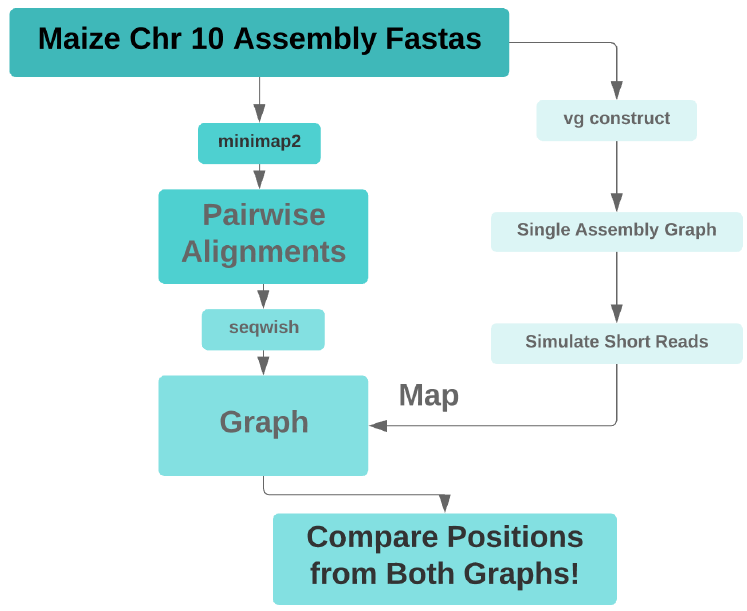
Figure 3. Pipeline diagram for mapper evaluation on Zea mays graphs. After constructing graphs with vg construct and with minimap2 and seqwish (Graph method 1), we sought to simulate reads from the vg construct graph, align them to the minimap2/seqwish graph with our faster, better short read mapper with hit chaining, and then to evaluate the mapper’s accuracy based on the simulated reads’ original and realigned positions along corresponding positional paths in the two graphs.